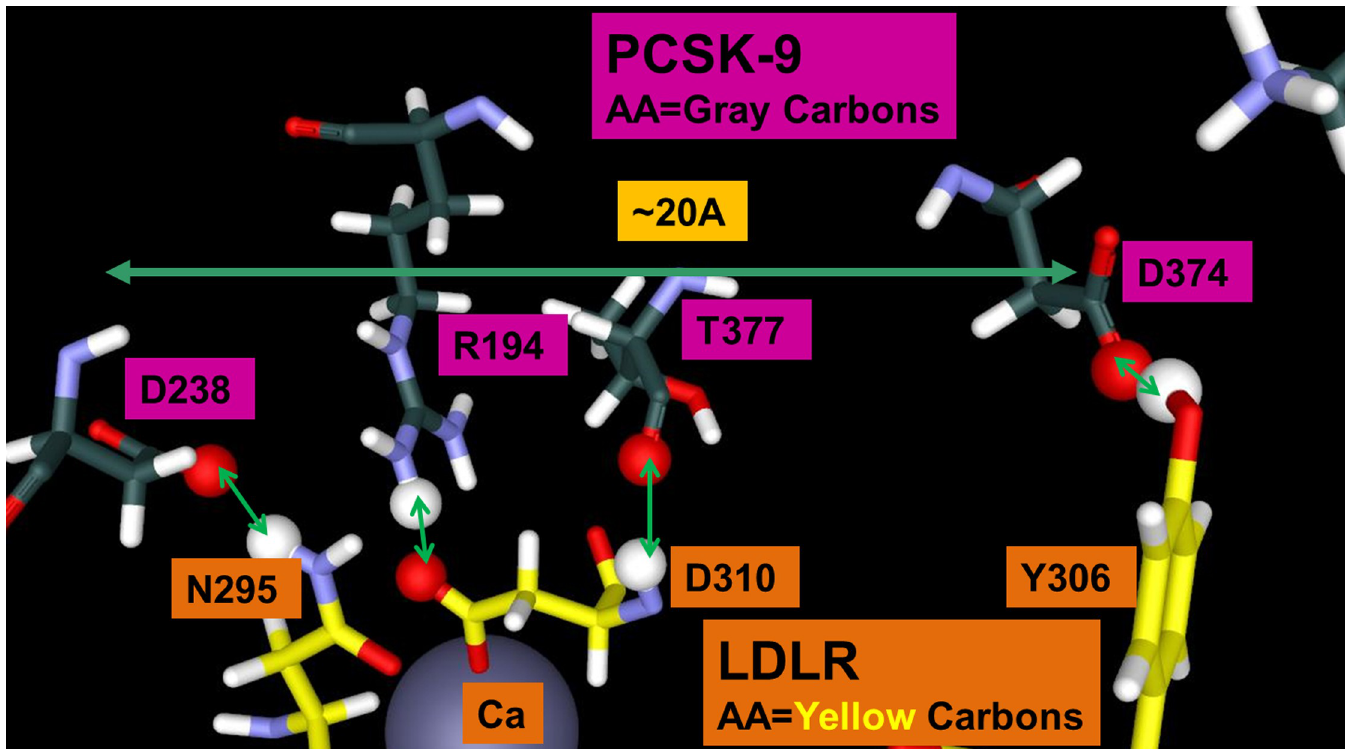
Fig 2. Four key PCSK9 interactions with LDLR. H306Y of LDLR shares its phenolic proton with D374 of PCSK9. LDLR D310 mediates electron sharing between the Ca 2 + ion of LDLR and R194 of PCSK9 by simultaneously chelating the metal and forming a salt bridge with R194. Further, the backbone of D310 forms a hydrogen bond with the backbone of T377 from PCSK9. LDLR N295 chelates the Ca 2+ ion and simultaneously forms a hydrogen bond with D238 of PCSK9. The PPI interface spans over 20 Å